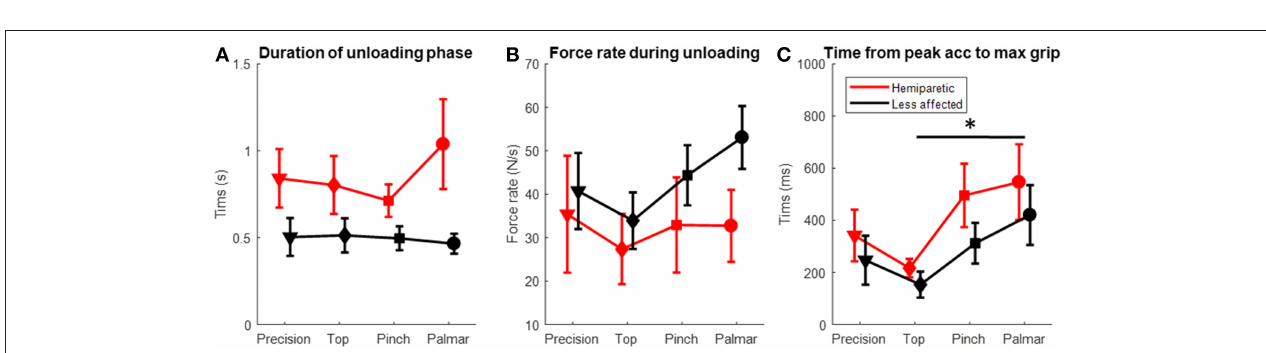
FIGURE 5 | Temporal data for unloading and lifting phases in the hemiparetic (red symbols) and less affected arms (black symbols) using different grasp configurations (in abscissa). (A) Duration of the unloading phase. (B) Time difference between maximal grip force and peak acceleration during the lifting phase. (C) Rate of grip force change during the unloading phase. *Dunn’s post-hoc p < 0.05.